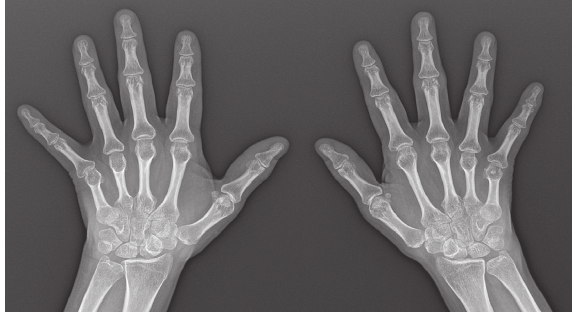
Figure 1: Plain radiographs of both